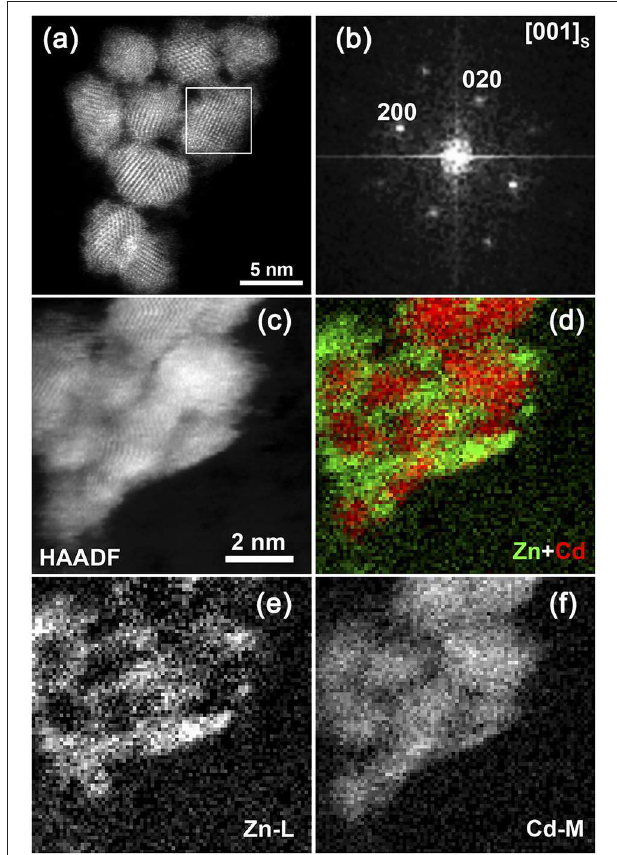
FIGURE 4 | (a,b) HAADF-STEM image of the ZnSe@CdS nanocrystals and Fourier transform of the selected area indexed in the zinc-blende structure; (c–f) HAADF-STEM image of the ZnSe@CdS nanocrystals, the maps of the Zn-L and Cd-M EELS signals and the color-coded mixed compositional